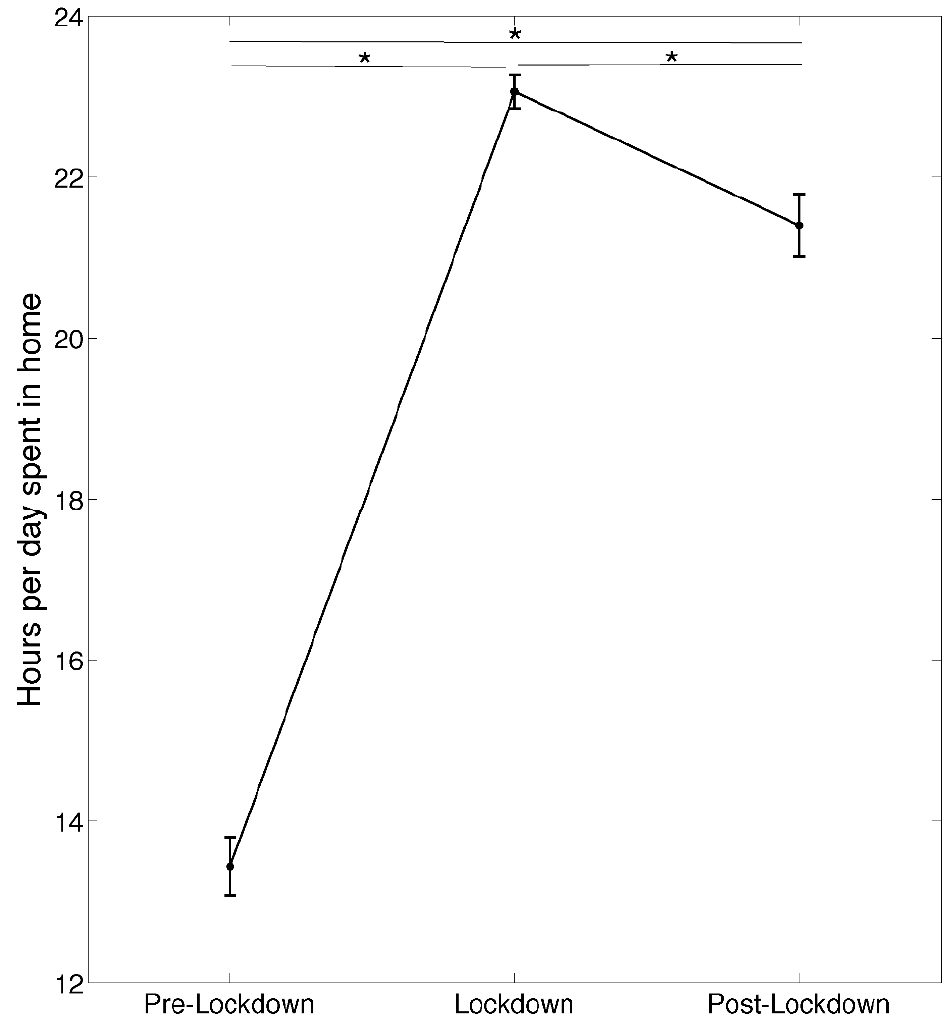
Figure 2. Results of the repeated-measures ANOVA performed on the hours per day spent at home in three time points: pre-lockdown, lockdown, and post-lockdown. Asterisks and thin black lines represent significant differences ( p < 0.05) between time points after LSD post hoc comparison.